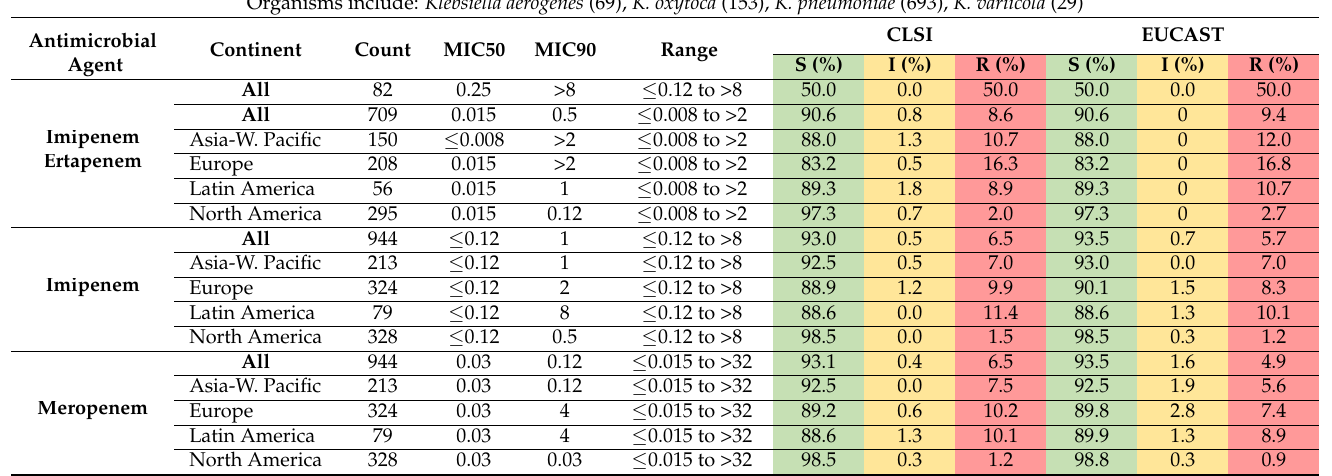
Table 4. Activity of antimicrobial agents tested against 944 Klebsiella isolates from intra-abdominal in- fections.